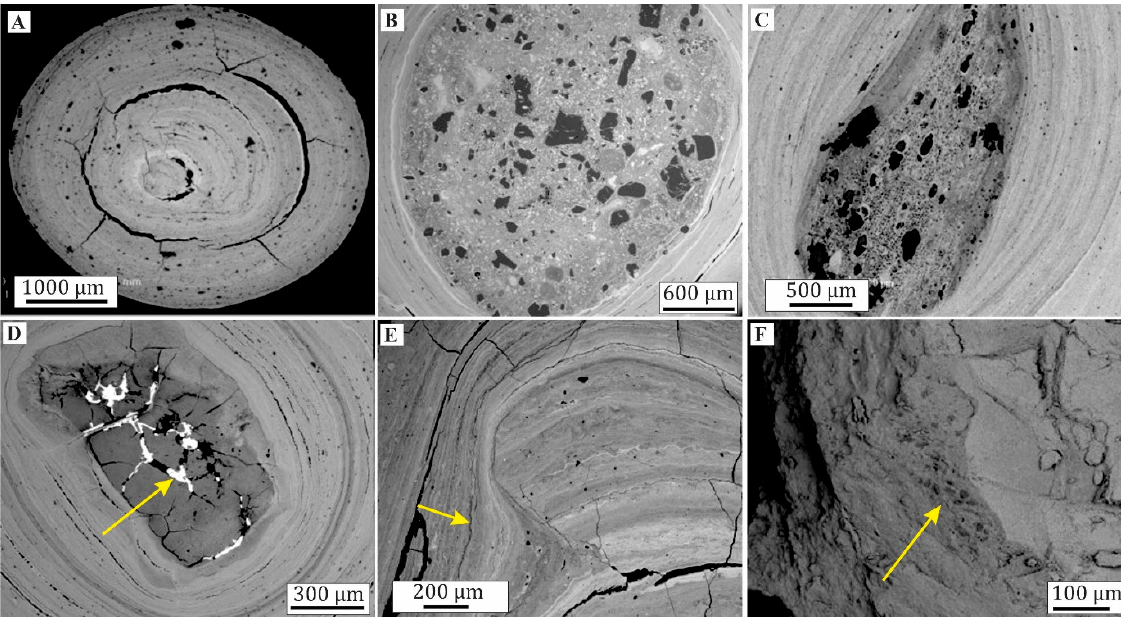
Figure 6. SEM micrographs of cross-sections through ferruginous pisoliths formed in the Perkolilli Shale (PPS). Micrographs show a variety of nuclei surrounded by multiple laminae typical of the paleochannel environment. Pisoliths showing well-developed goethite-rich multiple laminae that extend to the centre of the pisolith ( A ), encase a nucleus of quartz and clay ( B ), goethite-replaced wood fragments ( C ), and ferruginous clay ( D ). Barite partially infills the cracks and voids (arrow). ( E ) Pisolith showing discordant boundaries between sets of cortical laminae (arrow). ( F ) Internal surface of a broken pisolith showing a thin layer of quartz (arrow).